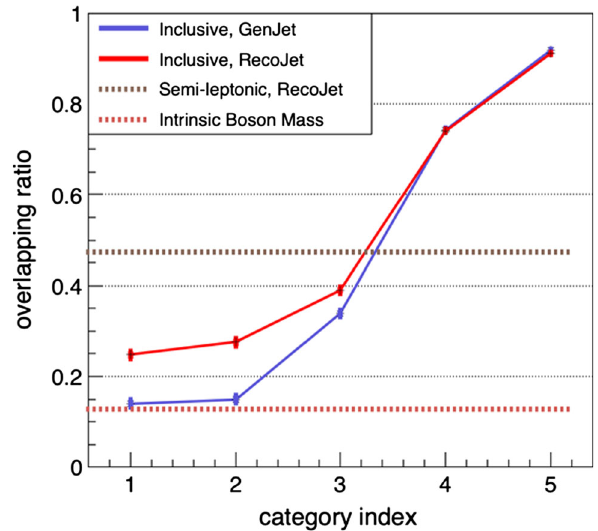
Fig. 16 The distribution of α ( α = α 1 × α 2 ) of the WW sample using the RecoJets. There are four vertical lines to characterize α into five